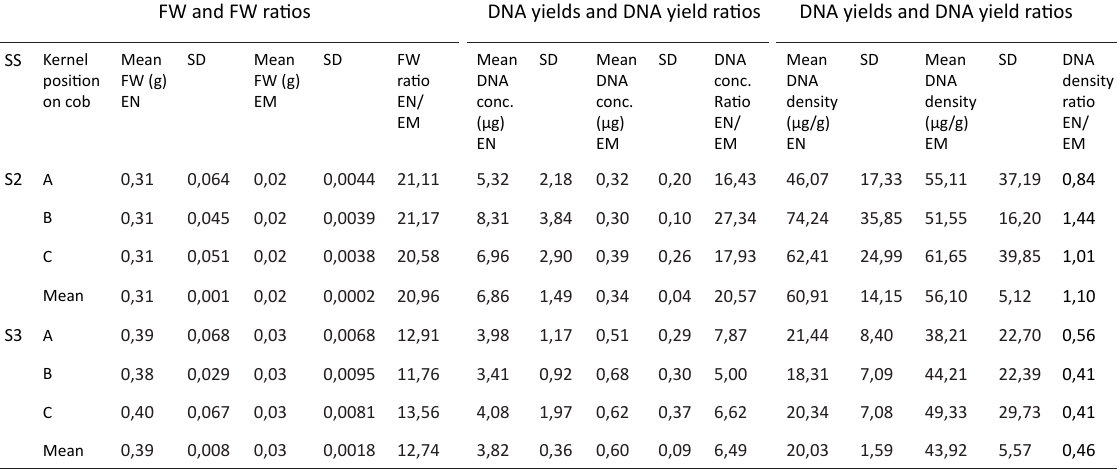
FW and FW ratios DNA yields and DNA yield ratios DNA yields and DNA yield ratios